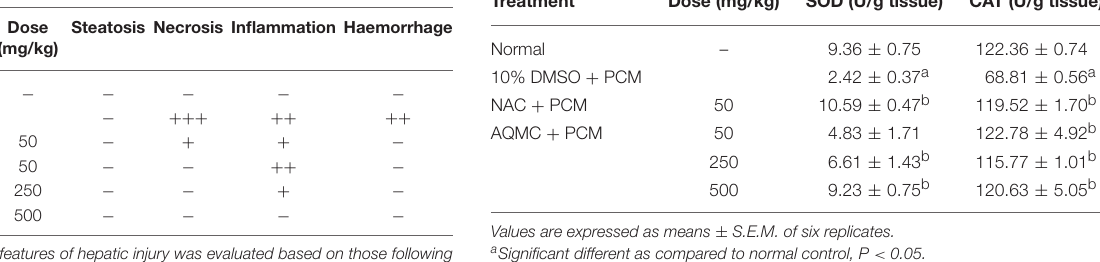
The severity of various features of hepatic injury was evaluated based on those following scoring scheme: − normal, + mild effect, ++ moderate effect, +++ severe effect.